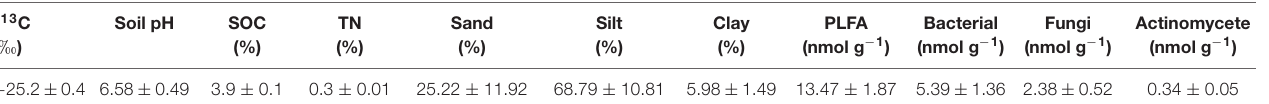
TABLE 1 | Soil properties used in this